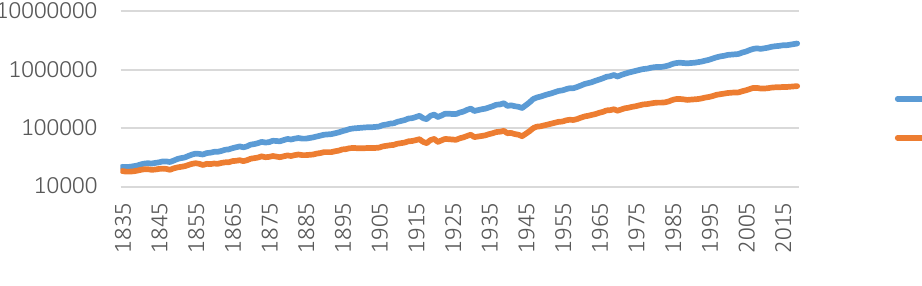
Figure 2b. GDP in 2015-NOK, 1835–2019 (semi-logarithmic scale) Figure 2. Historical energy consumption and GDP for